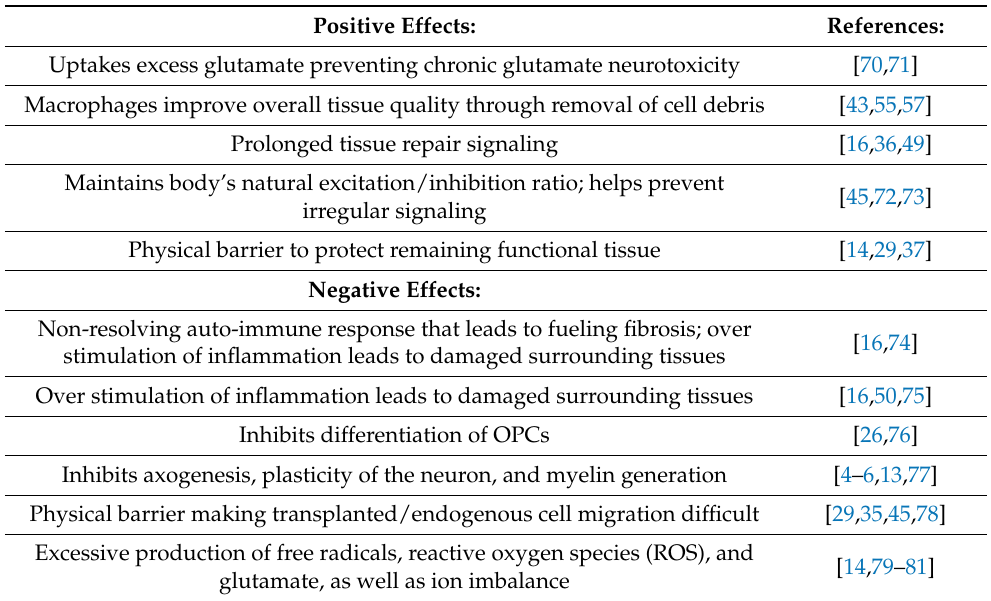
Table 1. Positive and negative effects of the glial